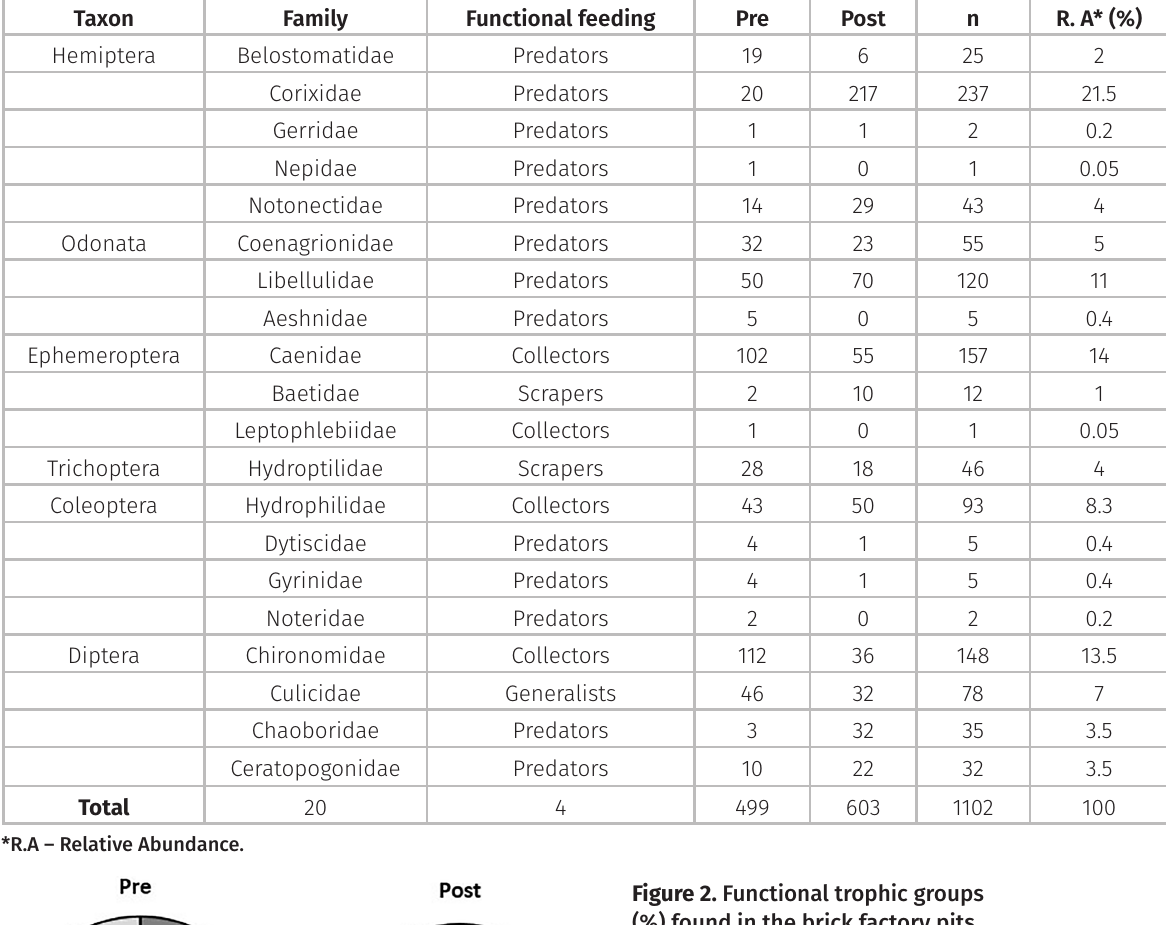
Figure 2. Functional trophic groups (%) found in the brick factory pits during the pre- and post-application of